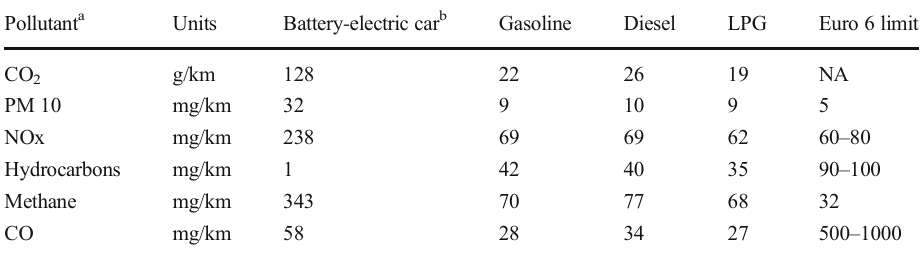
Table 4 Production emissions, Ford Focus, battery-electric, gasoline, diesel and